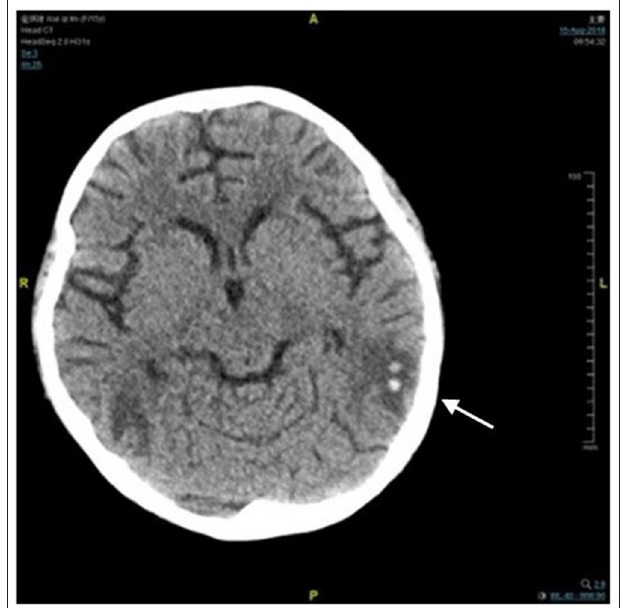
FIGURE 1 | Computed tomography image of brain. There was a small amount of hemorrhage in the left temporal lobe